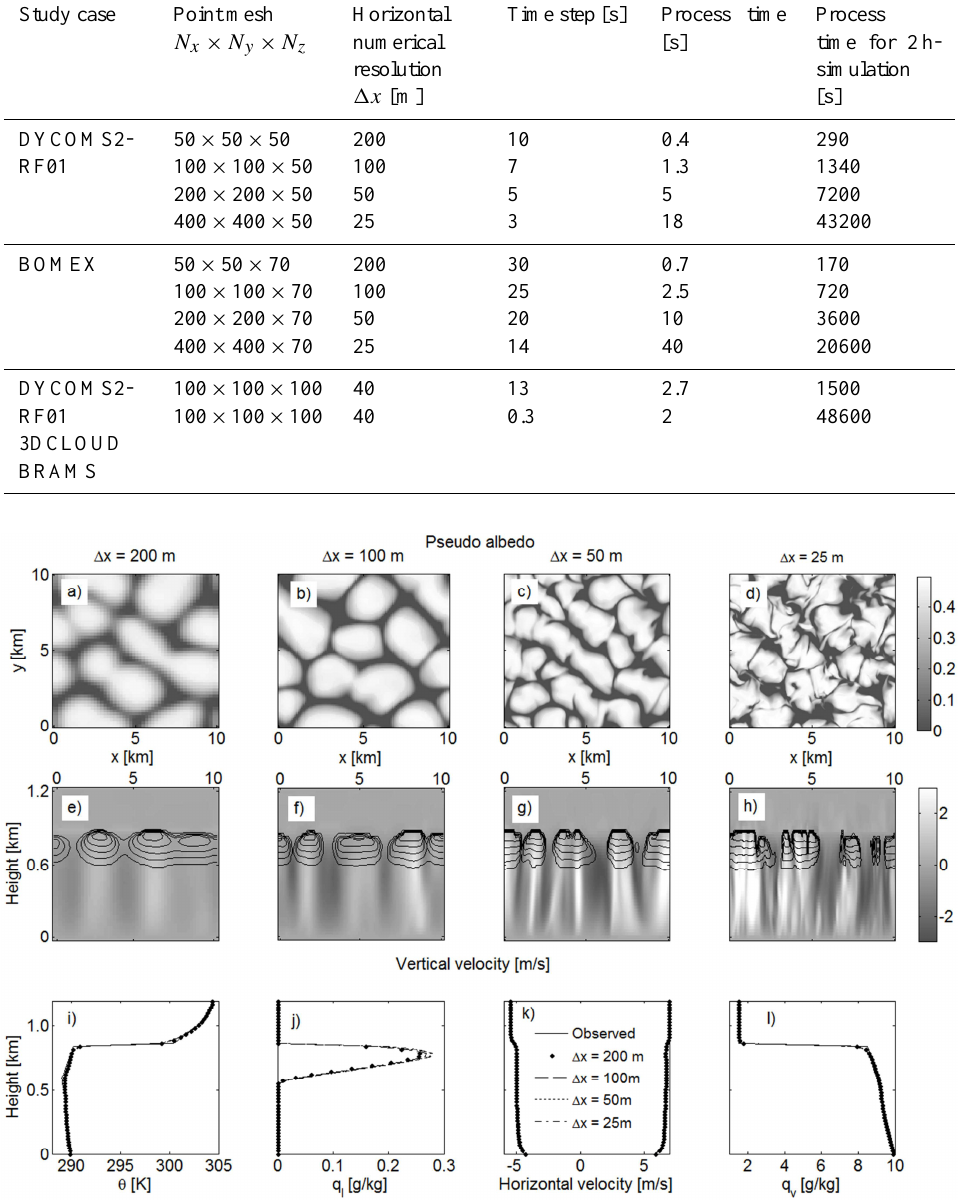
Figure 8. (a) , (b) , (c) and (d) pseudo albedo and (e) , (f) , (g) , and (h) cross sections of the vertical velocity (shaded) and the cloud water (contoured), at the end of simulation, for the stratocumulus simulated by 3DCLOUD with assimilation of meteorological profiles based on the DYCOMS2-RF01 case. Different numerical spatial resolutions are presented with 1x = 1y : (a) and (e) 1x = 200m, (b) and (f) 1x = 100m, (c) and (g) 1x = 50m and (d) and (h) 1x = 25m. (i) , (j) , (k) and (l) mean profiles of the potential temperature, the liquid water mixing ratio, the horizontal velocity components, and the vapour water mixing ratio. The solid lines indicate meteorological profiles based on DYCOMS2-RF01 case and assimilated by 3DCLOUD. Points, dotted lines, dashed lines and dash-dot lines indicate 3DCLOUD results at the end of simulation for the different numerical spatial resolution 1x = 200m, 1x = 100m, 1x = 50m and 1x = 25m, respectively. Number of iterations is